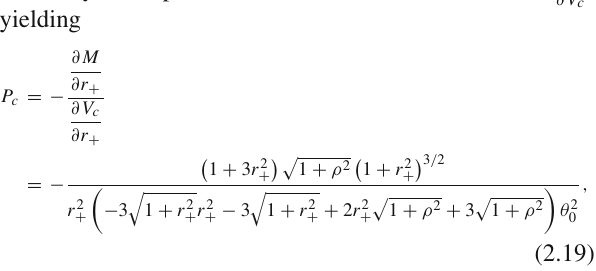
the fidelity susceptibility in the dual CFT part. The latter is defined as